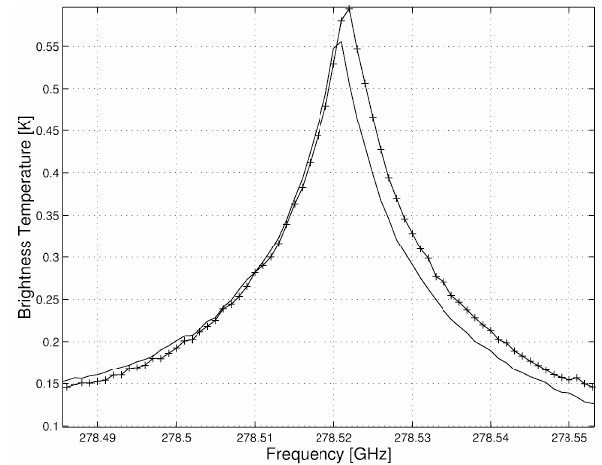
Fig. 8. Simultaneously estimated daytime profiles (stars) from noise-free synthetic spectrum of ( a ) O 3 , ( b ) ClO, and ( c ) NO 2 , together with: true profile (thick line) and a priori profile (dotted line), representative of a 15-minute integration time. Thermal noise error bars are given at 1- σ level. The shaded area corresponds to a vertical domain where an efficient retrieval is expected, namely W m > 0 . 7. Simultaneous retrievals from a noise-free spectrum rep- resent the best-case scenario, thus the conclusions drawn can be considered as optimal.